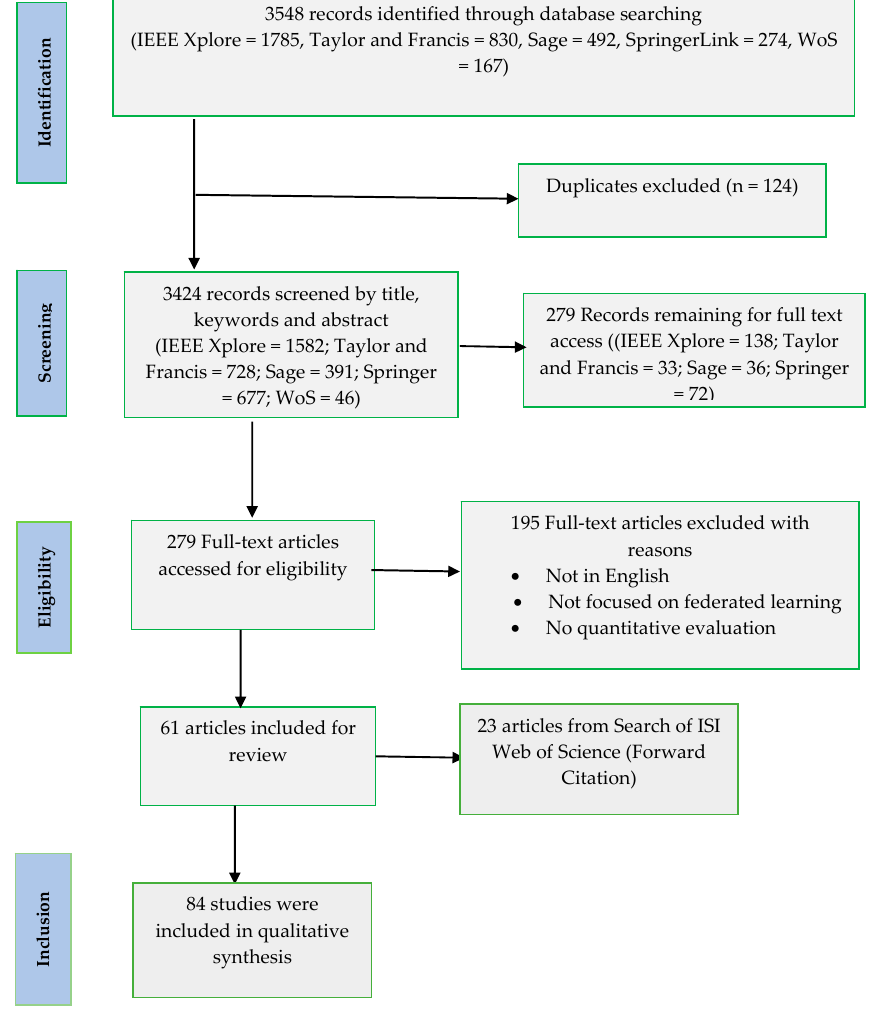
Figure 1. PRISMA flow diagram of paper selection employed in this review study.